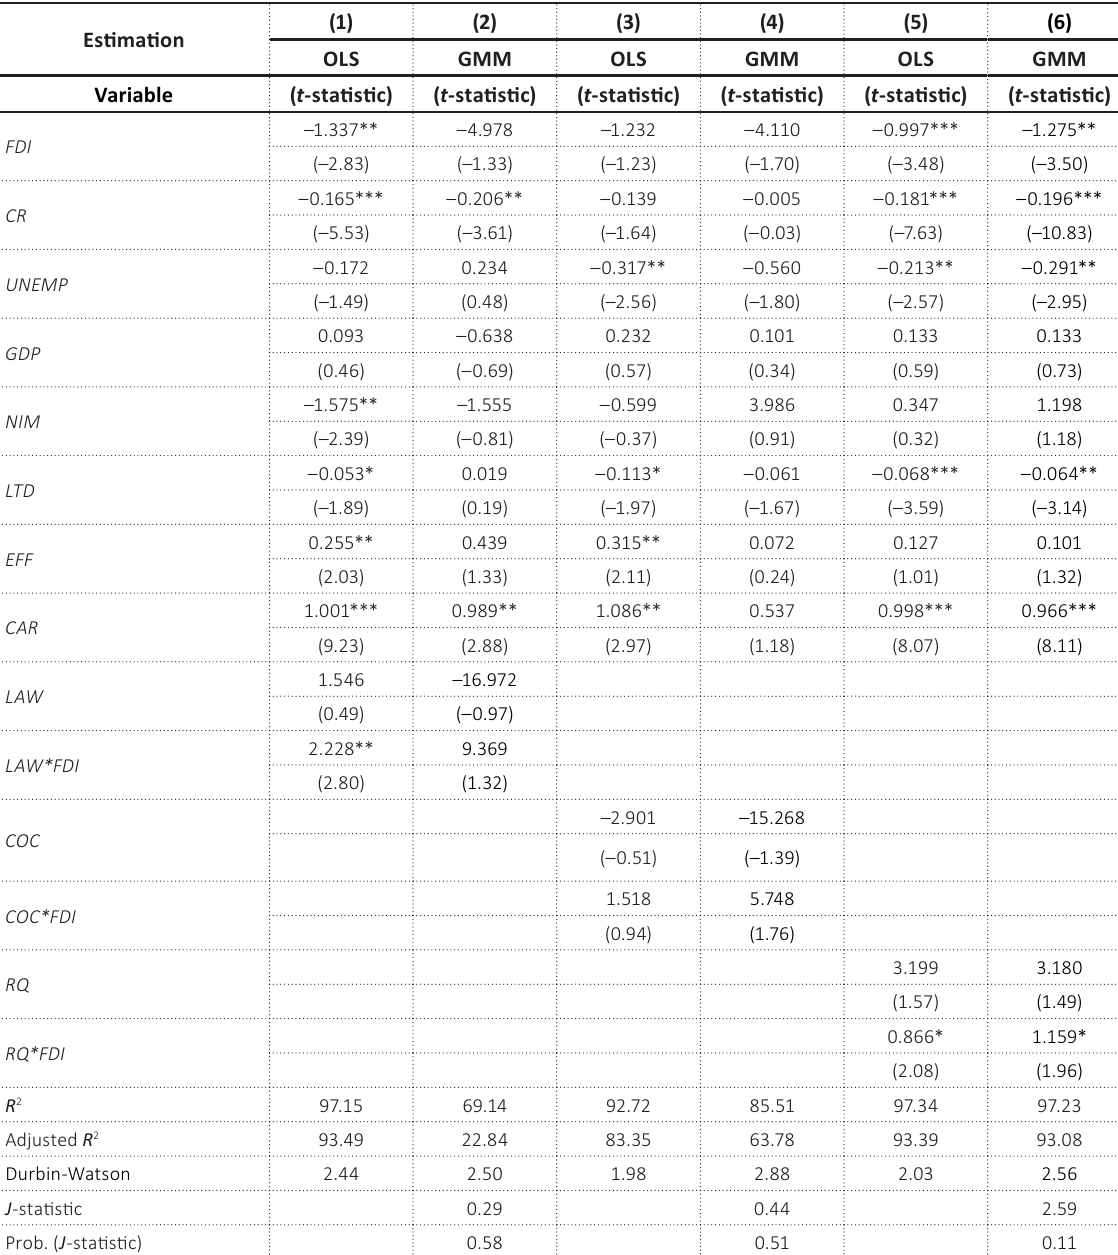
Table 6. Joint-effect of FDI inflows and country governance factors on NPLs